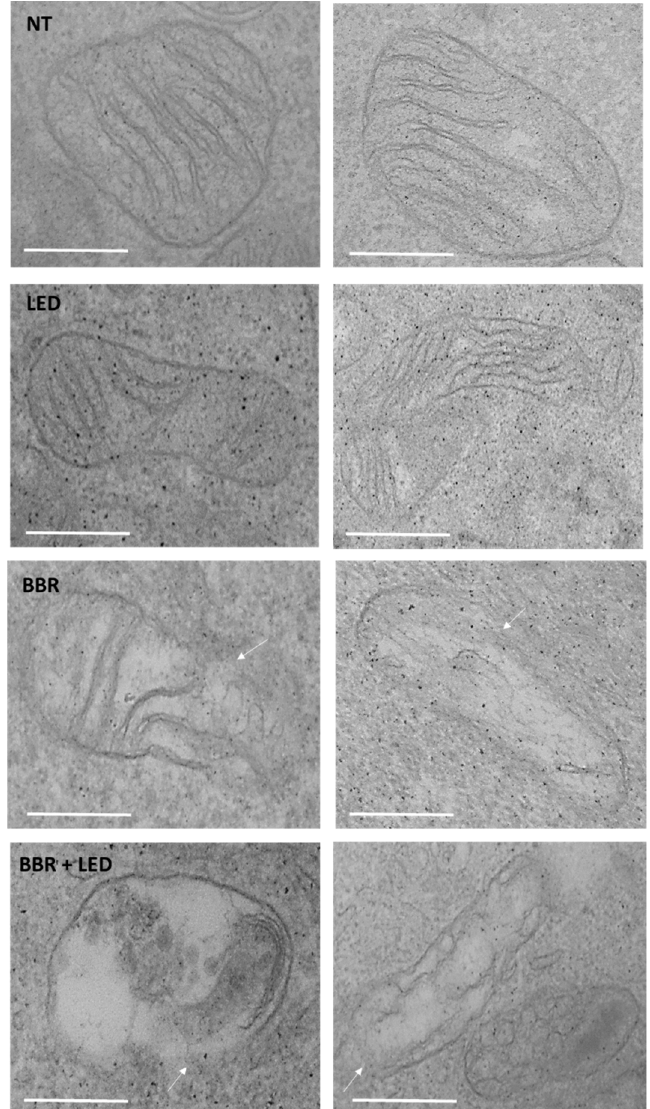
Figure 13. Ultrastructural analysis of mitochondria. T98G cells as untreated (NT), exposed to LED stimulation (LED), BBR (200 μ g/mL for 4 h) administration, and with the combined BBR + LED scheme, were trypsinized and analyzed by TEM after 24 h p.t. Arrows indicated mitochondrial membranes damages. Scale bars (0.5 μ m) are reported.